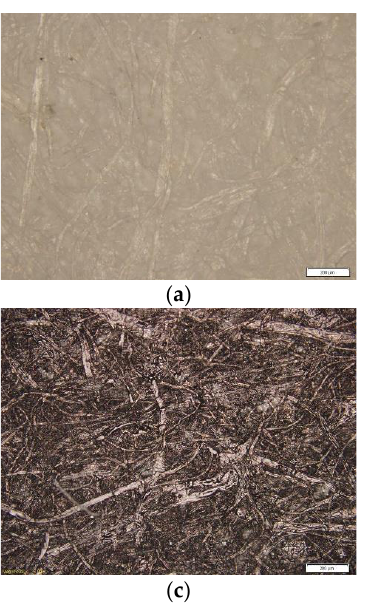
Figure 1. Microscopic images of the samples: ( a ) uncoated; ( b ) coated; ( c ) uncoated paperboard with ink film; ( d ) coated paperboard with ink film (mag. 50×).